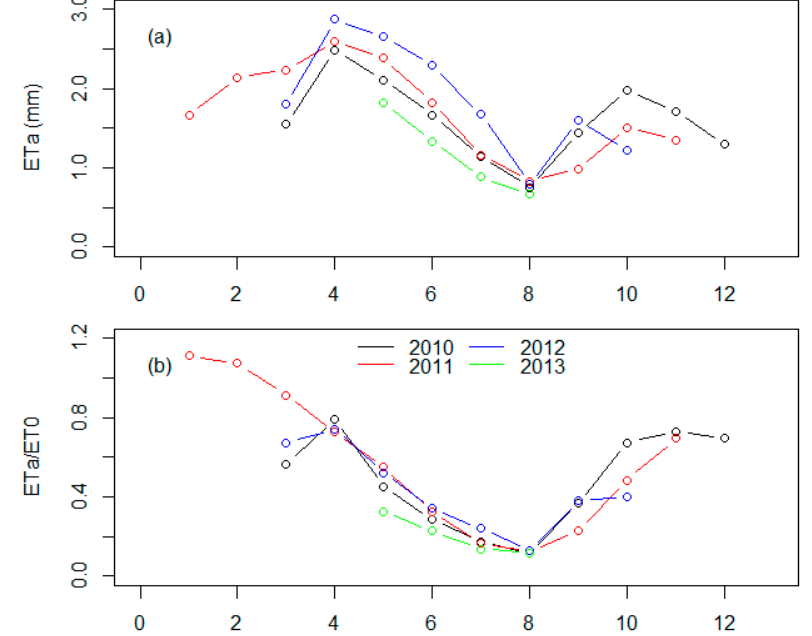
Figure 6. Seasonal evolution of the actual evapotranspiration at monthly time scale, during the four years of the experiment. ( a ) Actual evapotranspiration (ETa); ( b ) Ratio of actual evapotranspiration to reference evapotranspiration ET 0 .